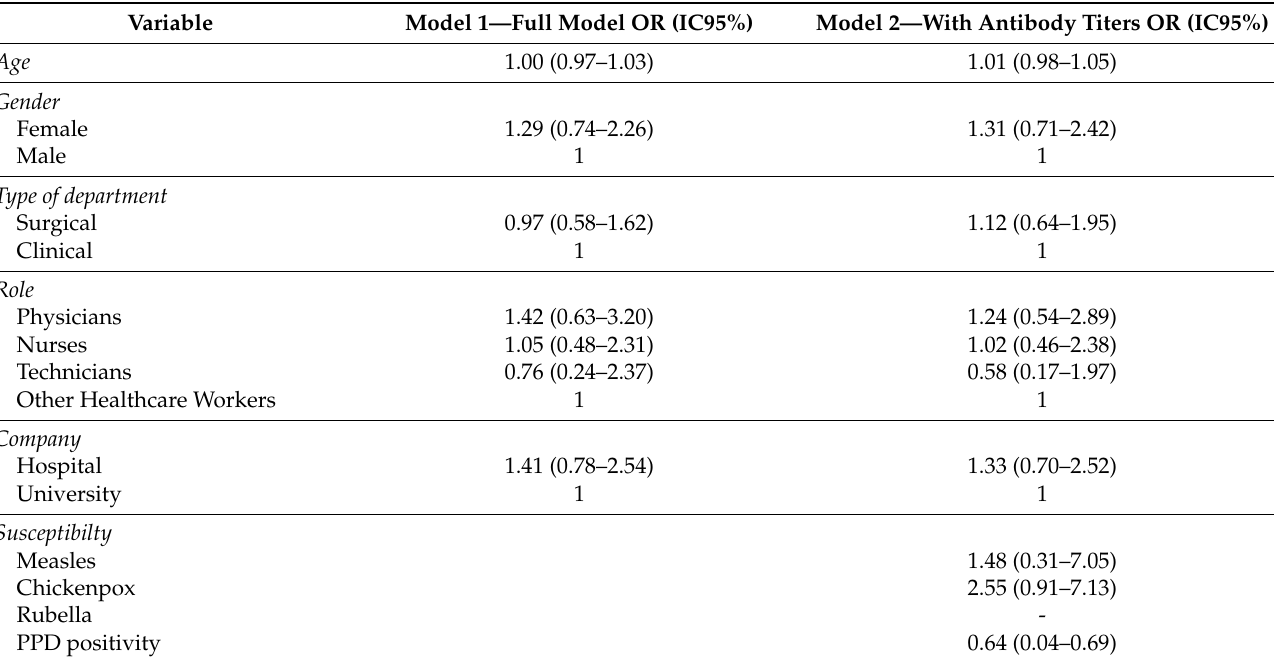
Table 5. Logistic regression analysis, dependent variable: rubella susceptibility.